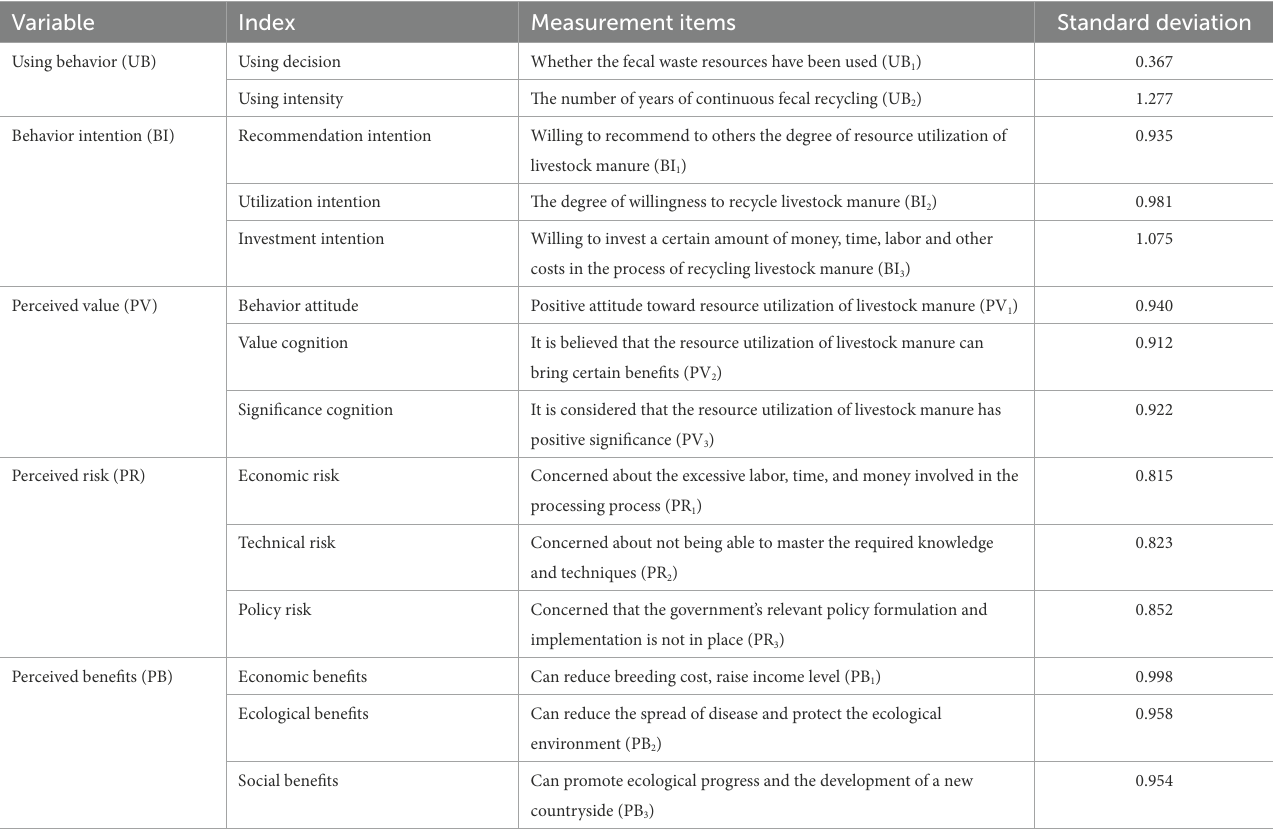
TABLE 2 Variable definition and measurement